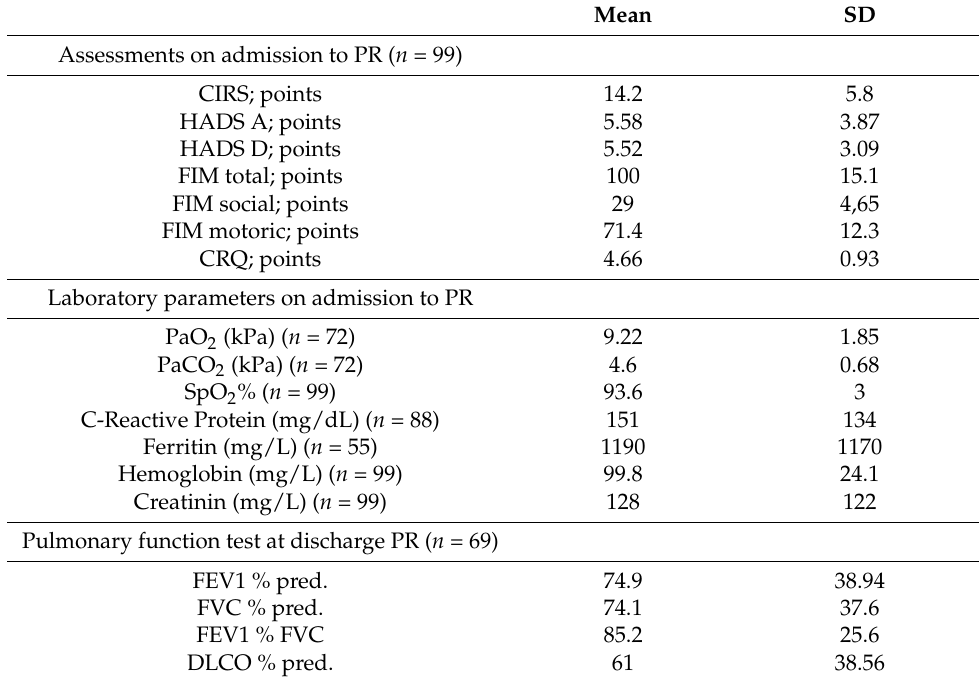
Table 5. Results of the assessments at admission to PR of the post-COVID-19 Group (PG).